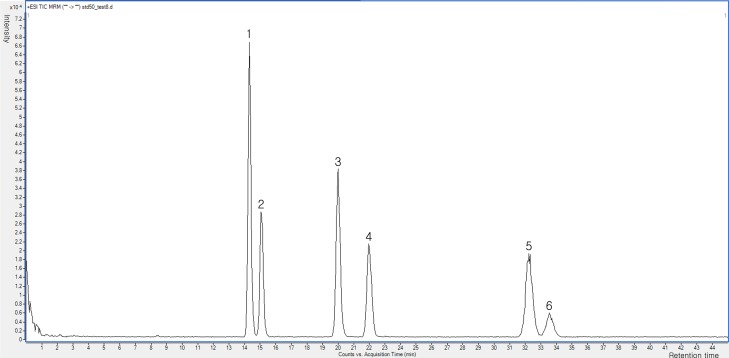
LC-MS/MS chromatograms of in a standard mixture of 6 zearalenone metabolites.Standard mixture of the six types of zearalenone group was put to 2 μL injection. (1) β-zearalanol(β-ZAL), (2) β-zearalenol(β-ZOL), (3) α-zearalanol(α-ZAL), (4) α-zearalenol(α-ZOL) (5) zearalanone(ZAN), (6) zearalenone(ZON).